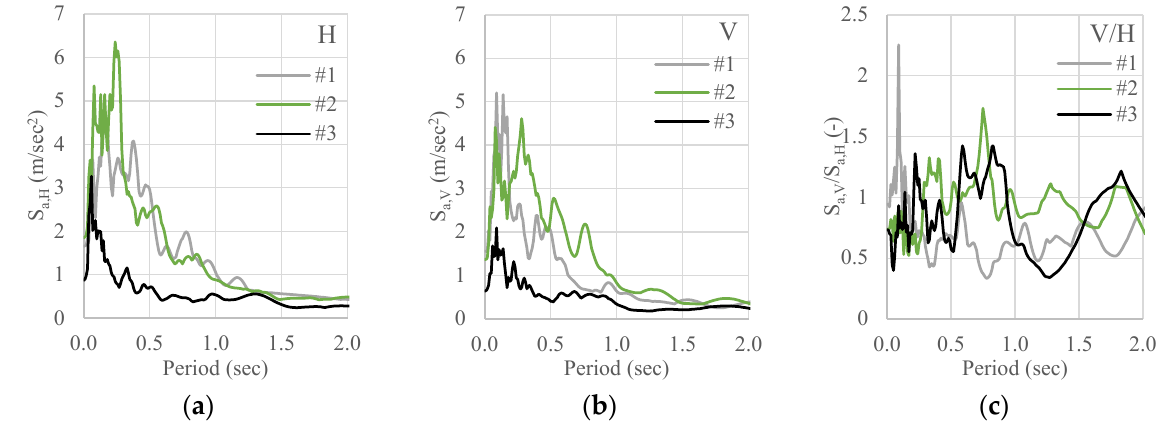
Figure 10. Response spectra of the H component ( a ) and V component ( b ) and ratio V/H for each period of the selected ground motion records ( c ).